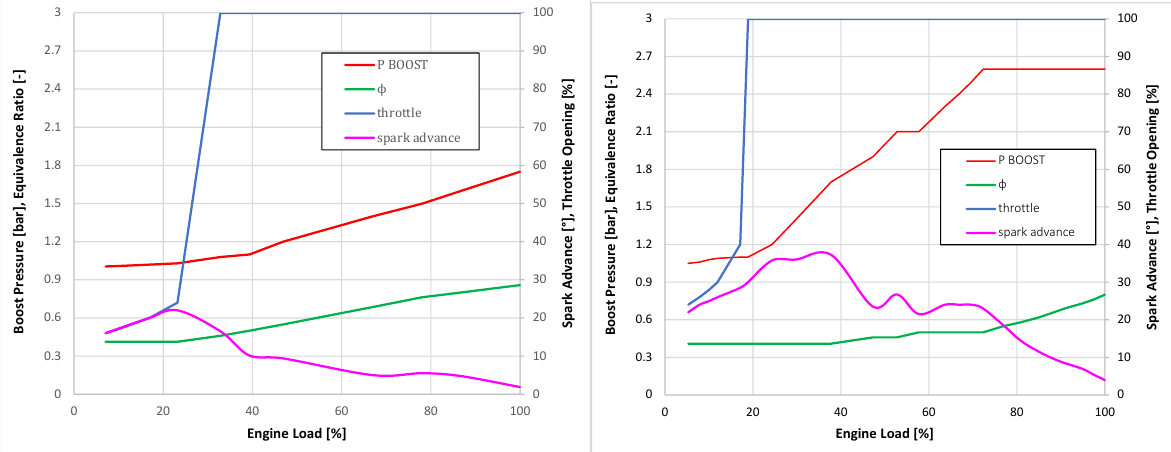
Figure 6. Optimized control parameters for the hydrogen engine running at 1500 rpm ( left ) 3000 rpm ( right ).